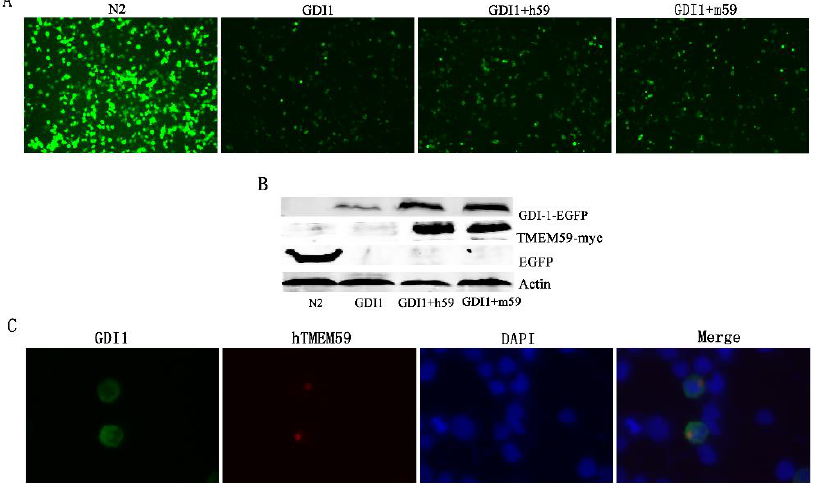
Figure 7. TMEM59 increases the protein amount of GDI1. ( A ) Overexpression of TMEM59 leads to retention of GDI1 in the cytoplasm. ( B ) TMEM59 increases the amount of GDI1 protein in HEK293T cells. Western blotting showed that overexpression of TMEM59 increases expression of GDI1. ( C ) TMEM59 and GDI1 show no obvious colocalization in the cytoplasm.